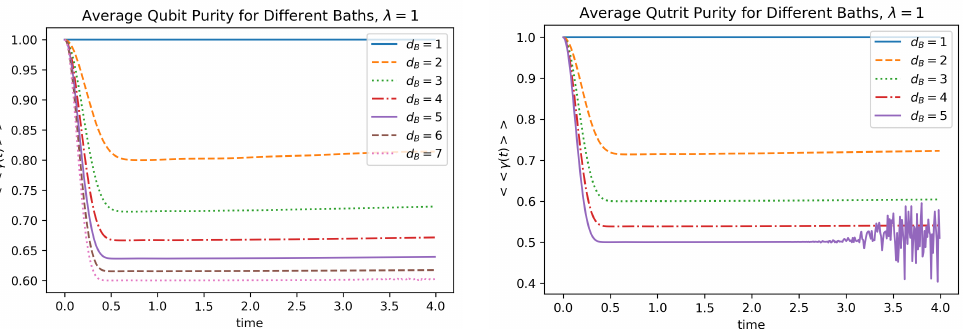
Figure 9: Dynamical GUE-averaged Subsystem purity 〈〈 γ ( t ) 〉〉 of a qubit, coupled to baths of d GUE variance λ = 1.